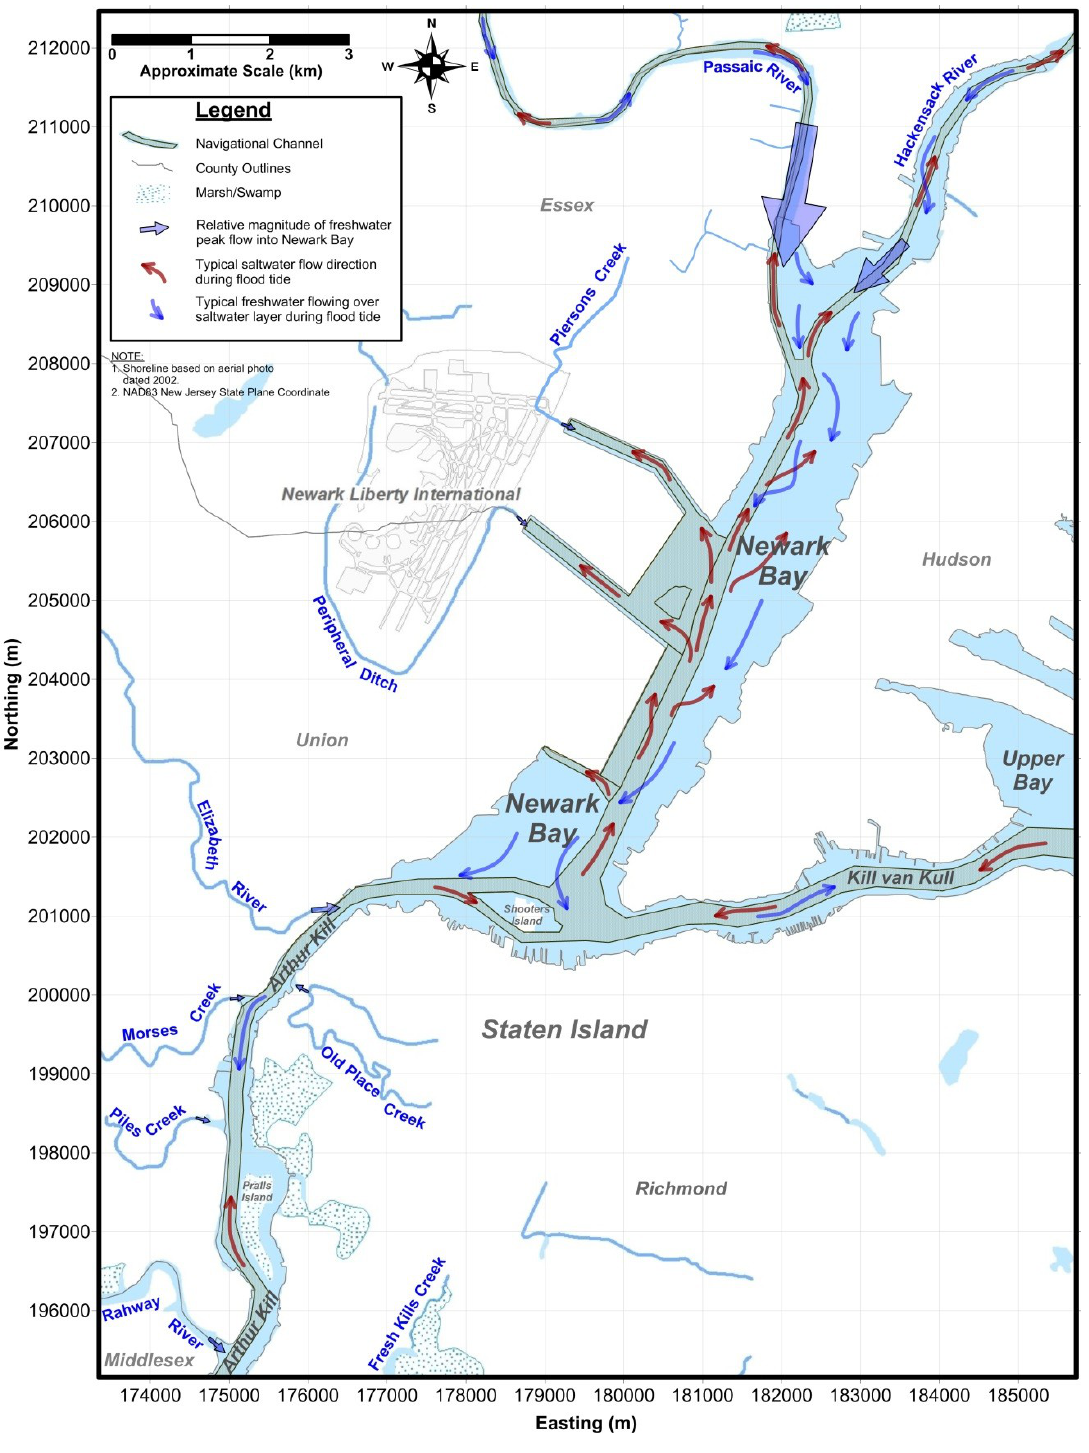
Figure 2. Freshwater flows into the NBSA where the size of the open arrows reflects the relative magnitude of the